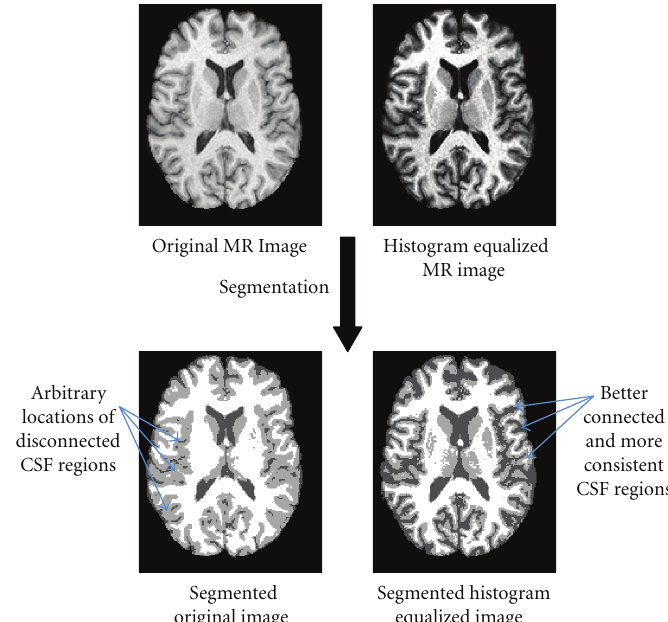
Figure 3: Demonstration of the e ff ects of histogram equalization on the segmentation. The top row shows the original image without histogram equalization on the left and a histogram equalized image on the right. The bottom row shows the corresponding hard segmented images. The arrows show smoother edges and better connected regions of the CSF class when histogram equalization is applied before segmentation. Arbitrarily located CSF spots have been removed, thereby increasing the consistency of the CSF class between di ff erent